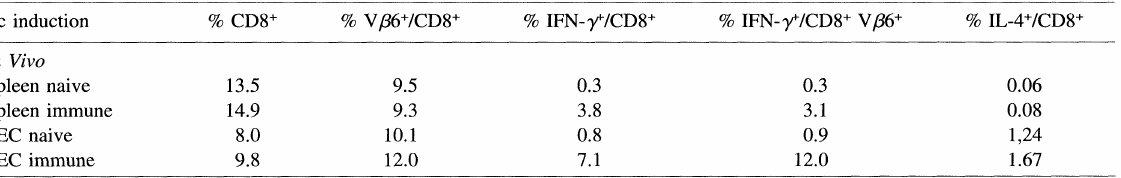
TABLE II Flow Cytometric Analysis of in vivo Induced ADJ-PC-5-Specific Tc